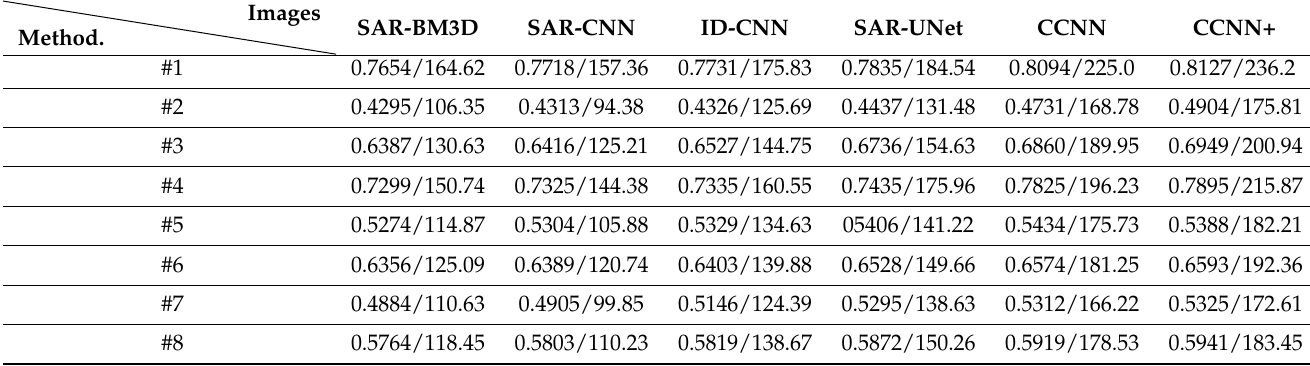
Table 3. Numerical comparison in terms of NIQE/ENL of different methods.